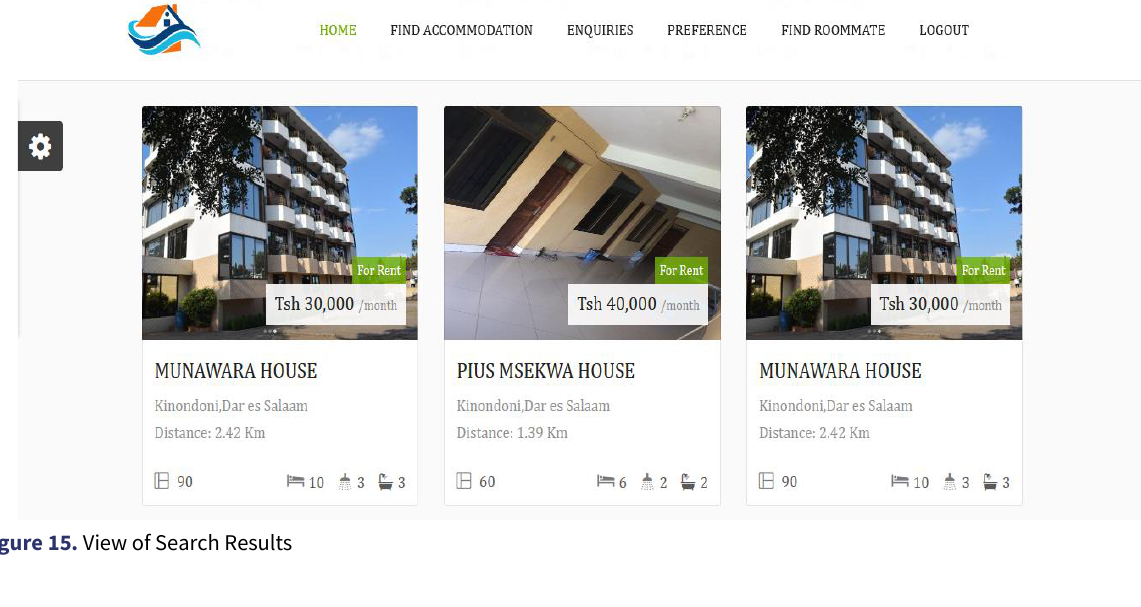
Figure 15. View of Search Results